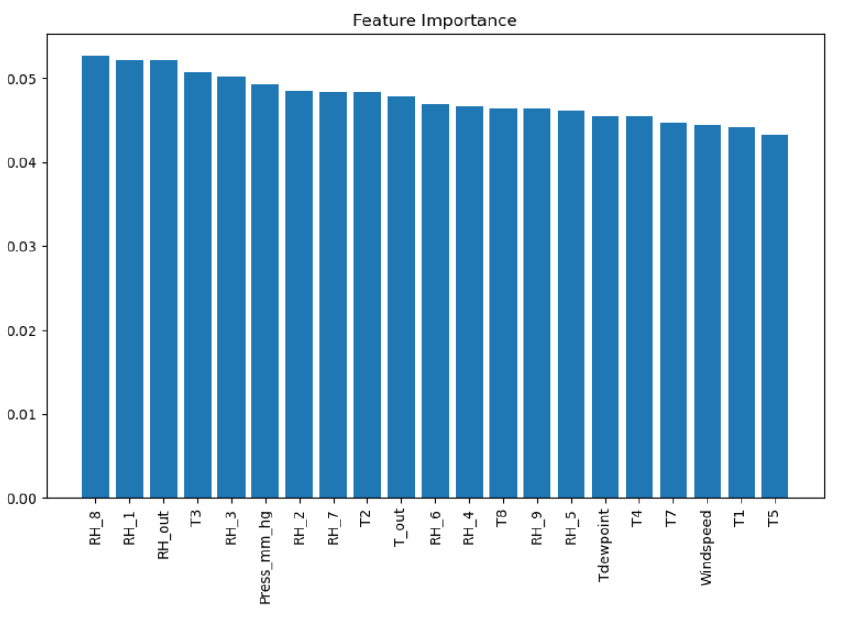
Figure 6. Filtered features’ levels of